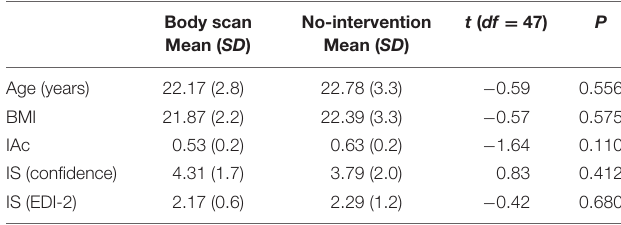
TABLE 2 | Descriptive variables of the body scan- and inactive control condition at